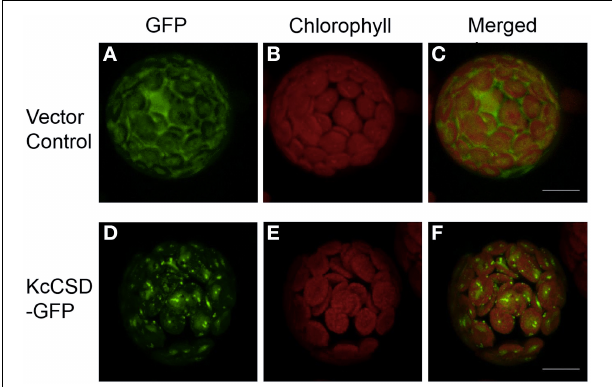
FIGURE 5 | Chloroplast subcellular localization of KcCSD. Determined by transient expression of GFP alone (vector control; A–C ) and a fusion KcCSD-GFP protein (KcCSD-GFP; D–F ) in Arabidopsis protoplasts. Green fluorescence of GFP (A,D) and red auto-fluorescence of chlorophyll (B,E) were monitored separately using a confocal laser scanning microscope, and the two color fluorescence images (C,F) were merged. Bars = 10 μ m.